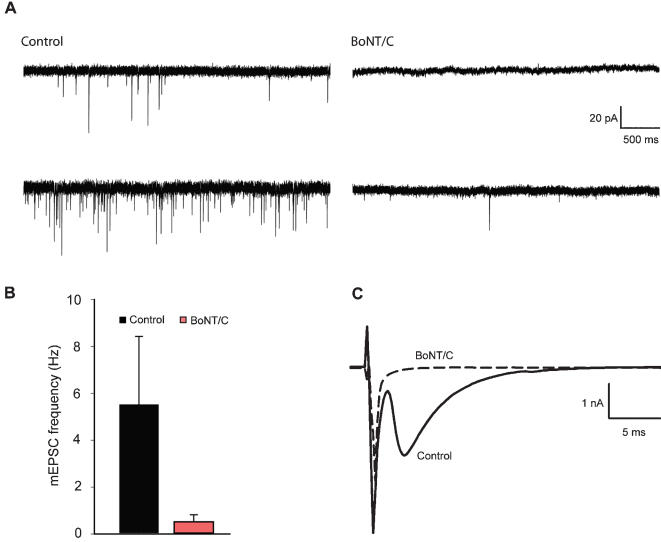
Spontaneous and evoked vesicle fusion is impaired in synapses lacking syntaxin. (A) Representative traces of mEPSC's in whole-cell voltage clamp recordings from control synapses showed frequent spontaneous miniature events, while syntaxin deleted synapses show a strong reduction of spontaneous release. (B) Frequency of spontaneous synaptic events. Numbers indicate mean±SEM for control (n = 5) and BoNT/C infected (n = 4) neurons from N = 2 different animals (***p<0.05, ANOVA and student's t-test). (C) Action potential triggered release is completely blocked by BoNT/C.